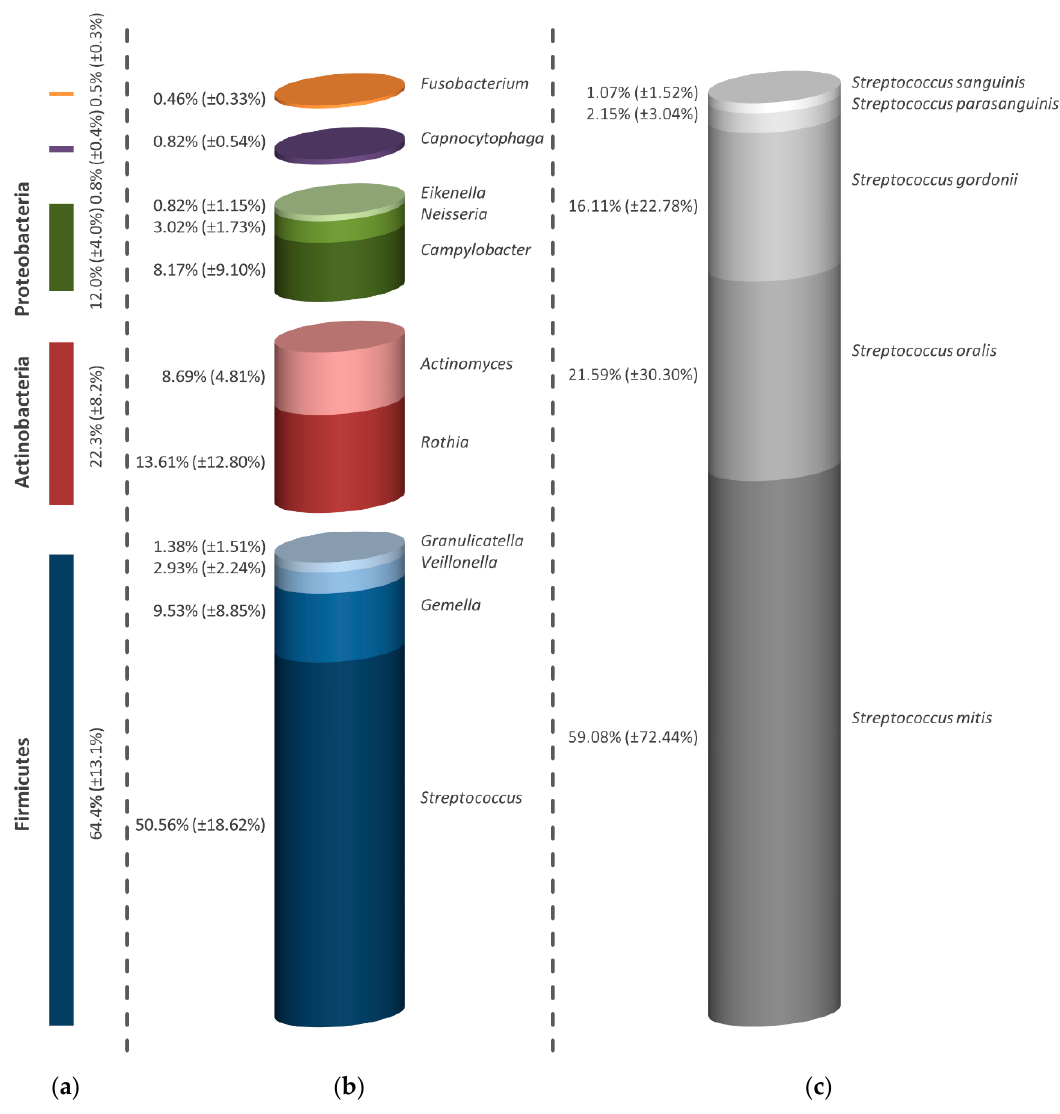
Figure 5. Illustration of the changed composition of the mature oral biofilm after treatment with 0.2% CHX. Division of diversity into bacterial strain ( a ), genus ( b ) and bacterial species of the proportionately largest genus ( c ). All determined percentages take into account the results of all examined subjects. The bars depict the average values in percentage of three discs (one from each volunteer). In addition to the average values, the standard deviations are also presented in parentheses.